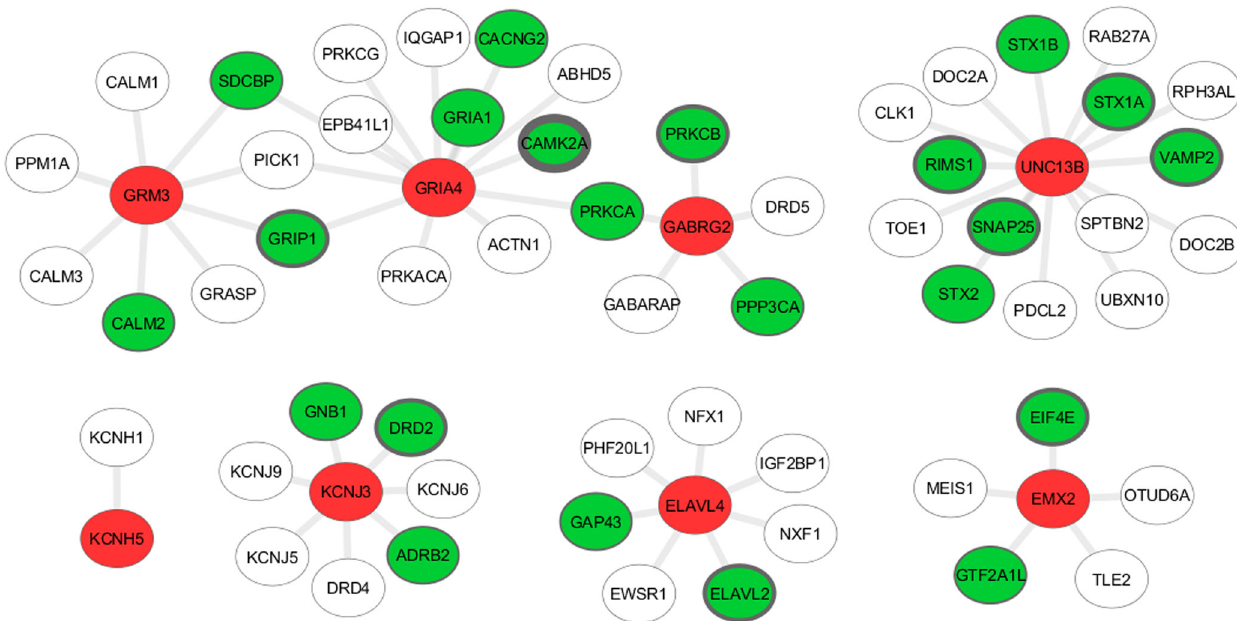
Fig. 3 Modules of the identi fi ed ASD risk genes in the PPI network used for signal diffusion. Red nodes denote the new potential risk genes and green nodes represent existing ASD-associated risk genes. Width of borders of the green nodes represent the number of evidences available on this gene regarding its association with ASD in that thicker boundaries indicate larger